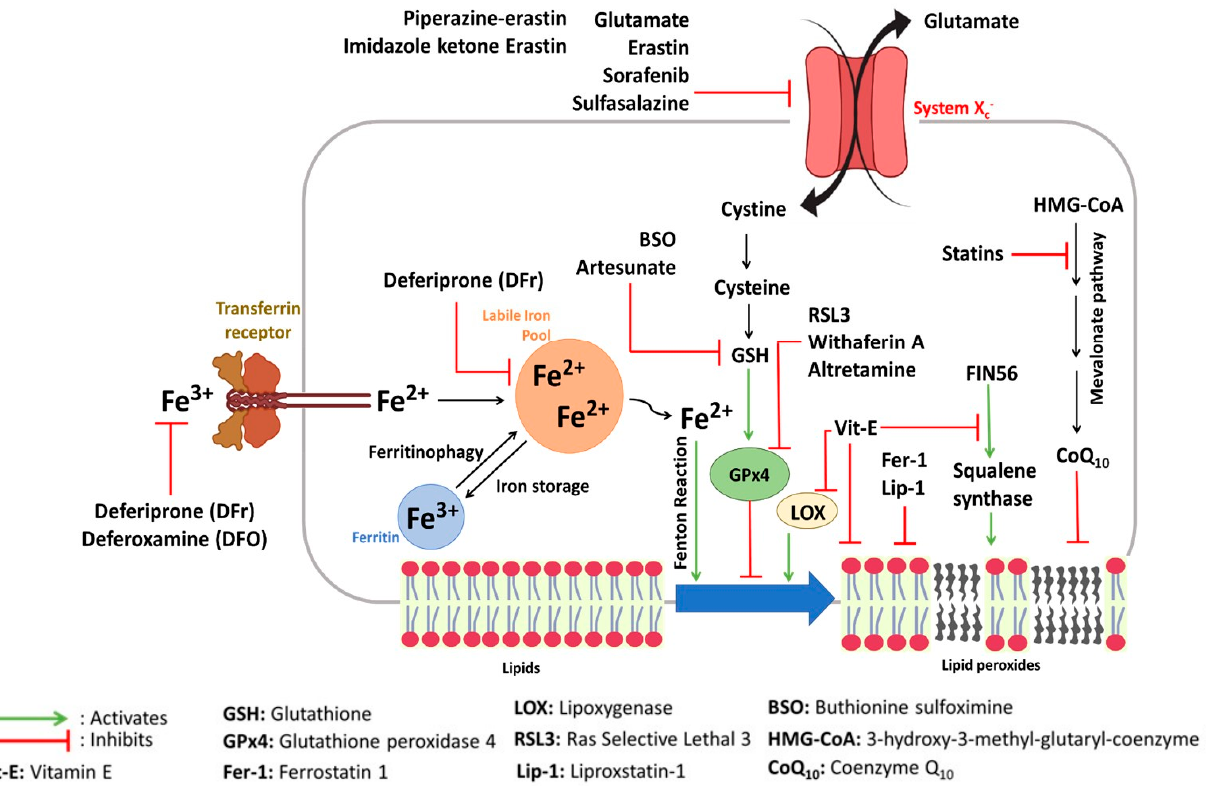
Figure 5. Network of ferroptosis inducers and